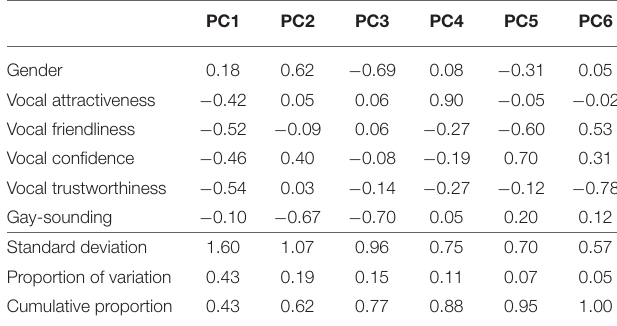
TABLE 6 | The cumulative proportion of variance accounted for and loadings from the PCA of the vocal impression ratings.